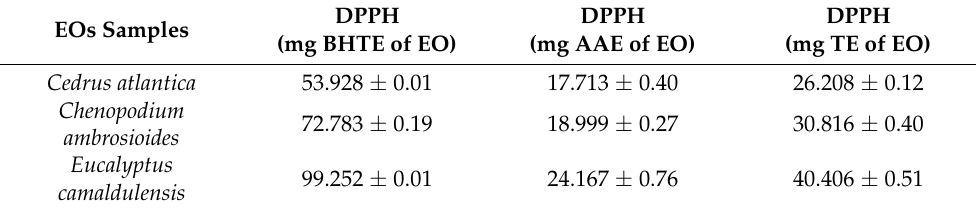
Table 2. Antioxidant activity of EOs, values are given as means of three replicates ± SD. EOs Samples